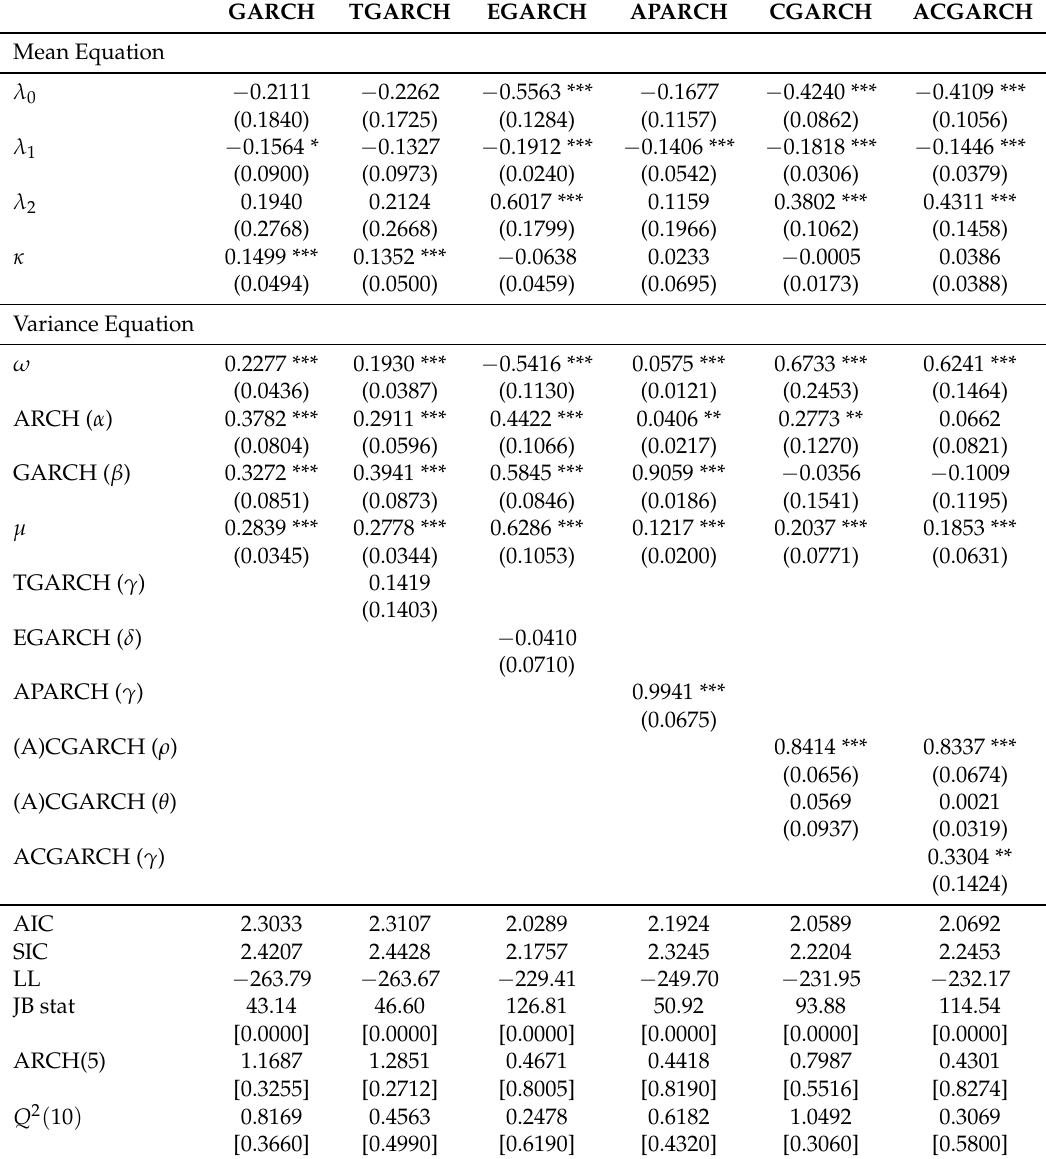
Table A13. GARCH-M Tests for Bitcoin Cash for the recovery